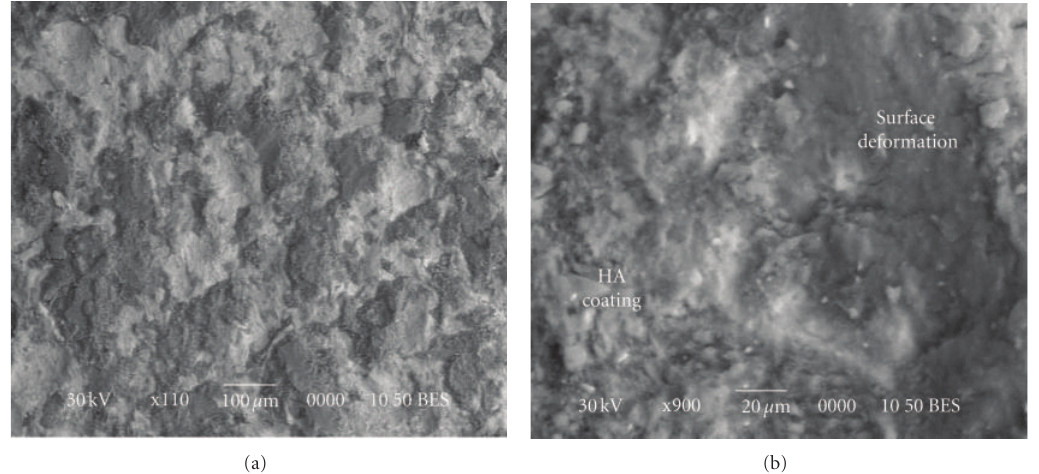
Figure 16: Backscattered electron images of the as-synthesized SiHA coating after one hour of mechanical treatment.